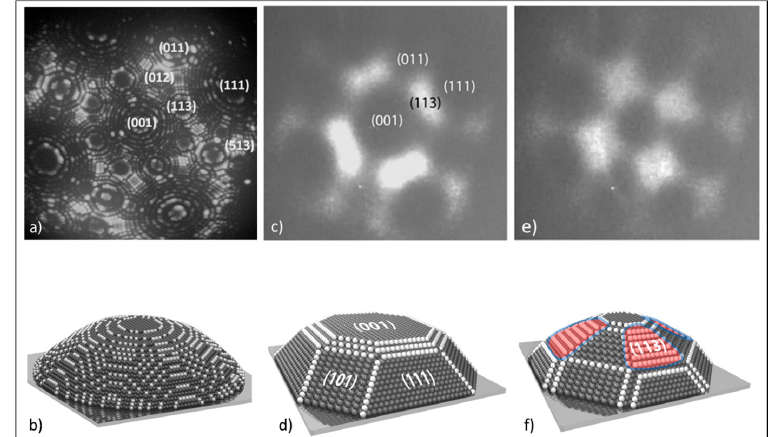
Figure 4. Analysis of surface reconstruction by FIM/FEM: ( a ) FIM micrograph of a Ni crystal tip and the corresponding Miller index annotations. The magnification corresponds to ~10 6 on a detector screen of 3 inches diameter. Conditions of acquisition: T = 61 K, F = 3.5 V/Å; ( b ) corresponding ball model where withe balls represent kink and step sites; ( c ) FEM micrograph of the same crystal under